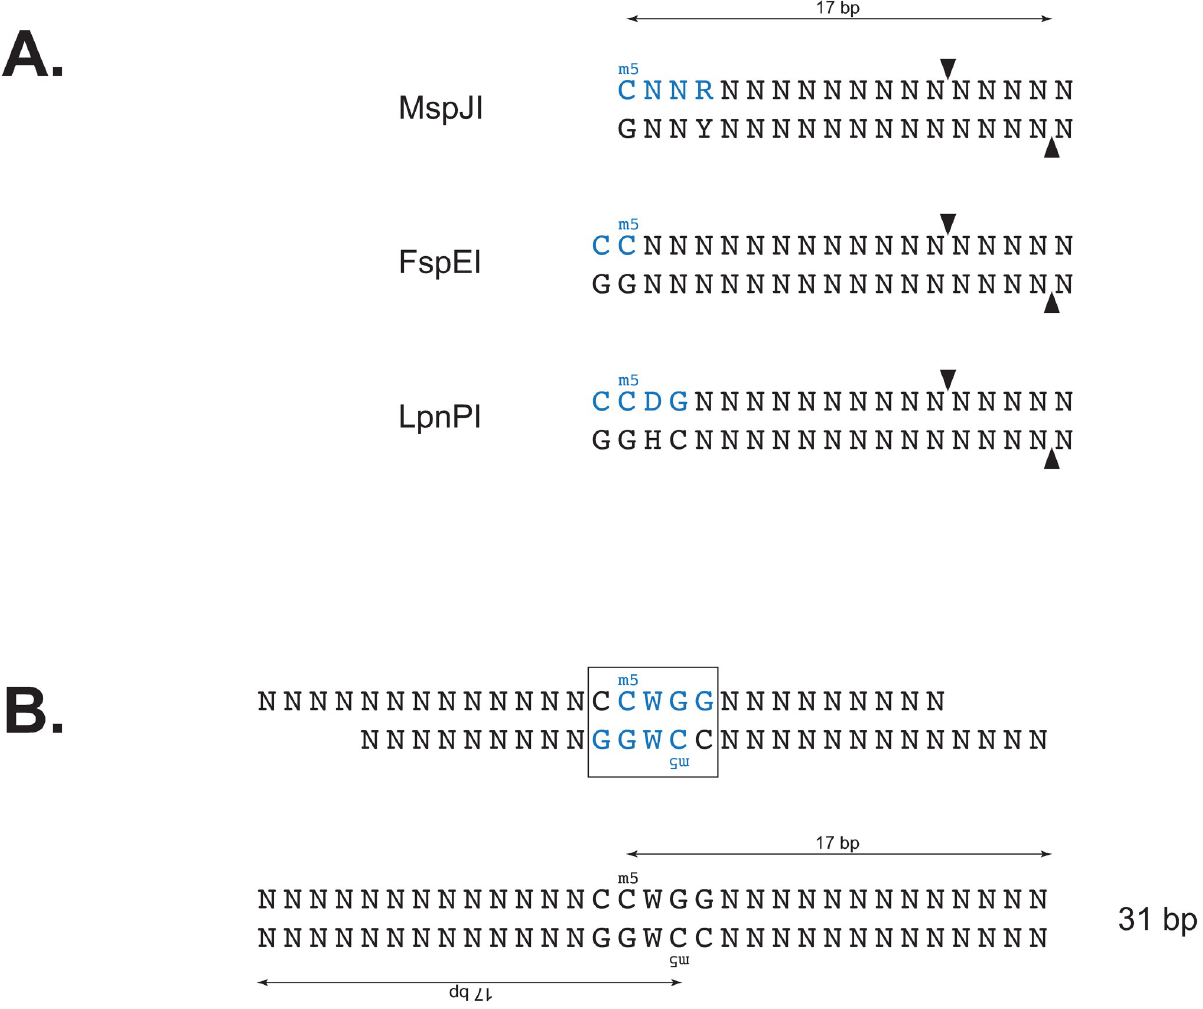
Fig 1. MFRE cleavage and formation of library inserts. A) Recognition sites (blue) and cleavage positions (arrows) of three commercially available MFREs. B) Product of MspJI (recognition site in blue) cleavage of the fully methylated motif CCWGG (boxed), before and after end repair. The m5C residue on each strand is the 17 th base from the 3’